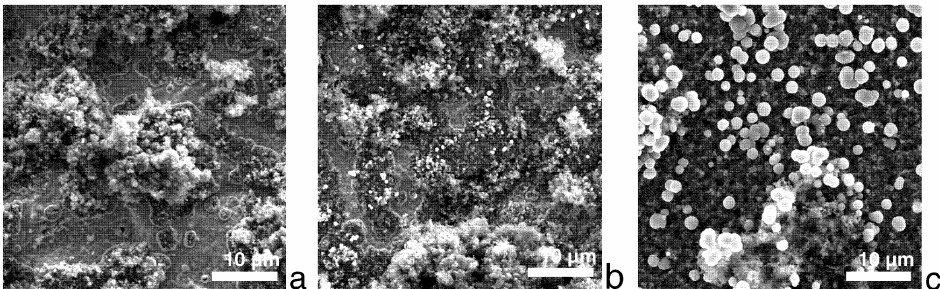
Figure 2. C µ Ss growth mechanism. Deposition time: ( a ) 5 min, ( b ) 15 min and ( c ) 30 min.